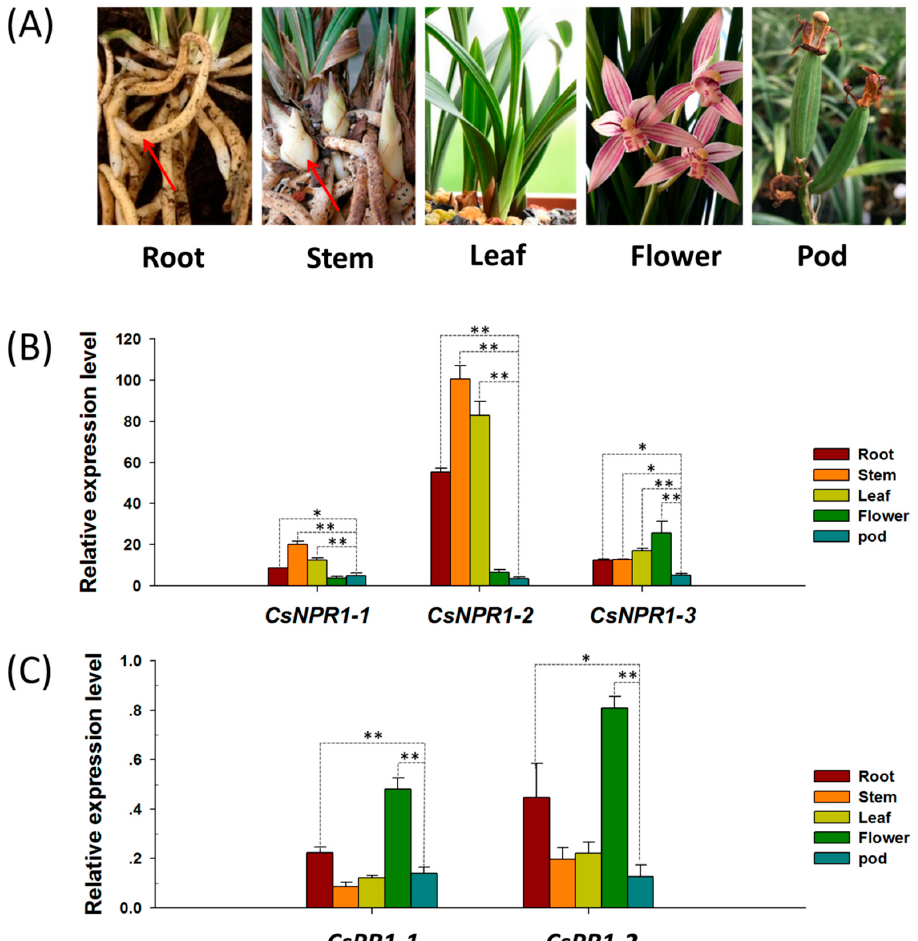
Figure 3. Tissue/organ specific expression analysis of CsNPR1 and CsPR1 genes. ( A ) Different tissues/organs (root, stem, leaf, flower and pod) were collected for total RNA isolation; and the expression patterns of ( B ) CsNPR1 and ( C ) CsPR1 genes were examined by qRT-PCR. Y-axes indicate relative expression levels; significant di ff erence was assessed by Mann–Whitney U-test and indicated by asterisks; single asterisk (*) represents p ≤ 0.05, double asterisk (**) represents p ≤ 0.01; Data are expressed as the mean of three biological replicates, with error bars indicating the SD (standard